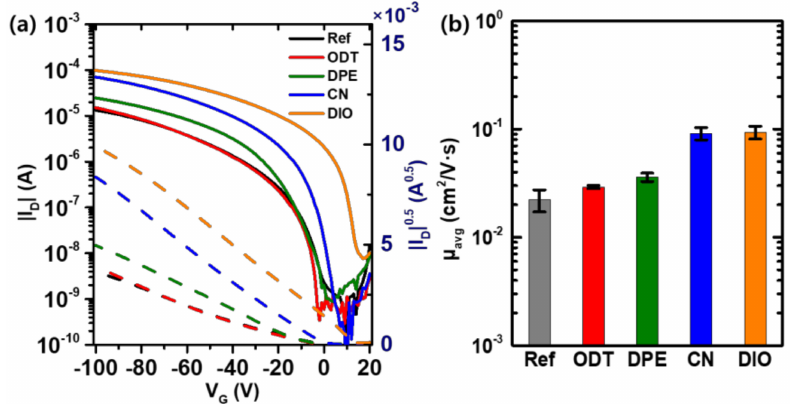
Figure 4. ( a ) Characteristics of organic field-effect transistors (OFETs) based on P3HT processed with various additives. ( b ) Comparison of hole mobility. The films were thermally annealed at 120 ◦ C for 30